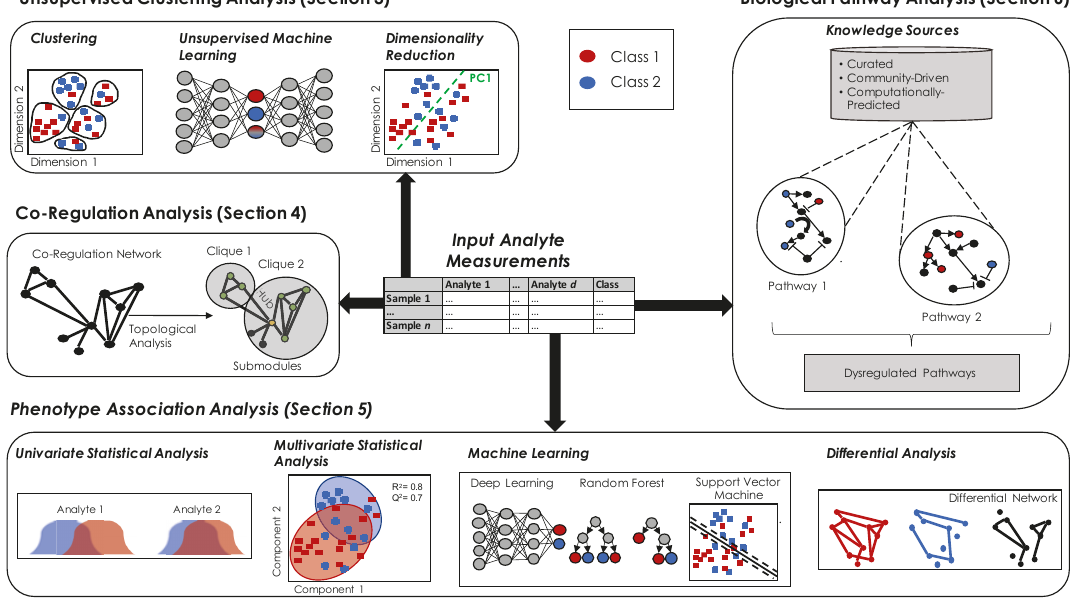
Figure 2. Analysis techniques on a dataset with n samples and d analytes in two classes. Blue represents one class of samples, and red represents another class of samples. Class typically corresponds to phenotype but could also correspond to batch or another variable of interest. Analyses include unsupervised clustering approaches (Section 3), modeling co-regulation (Section 4), approaches for identifying analytes associated with class (Section 5), and pathway analysis (Section